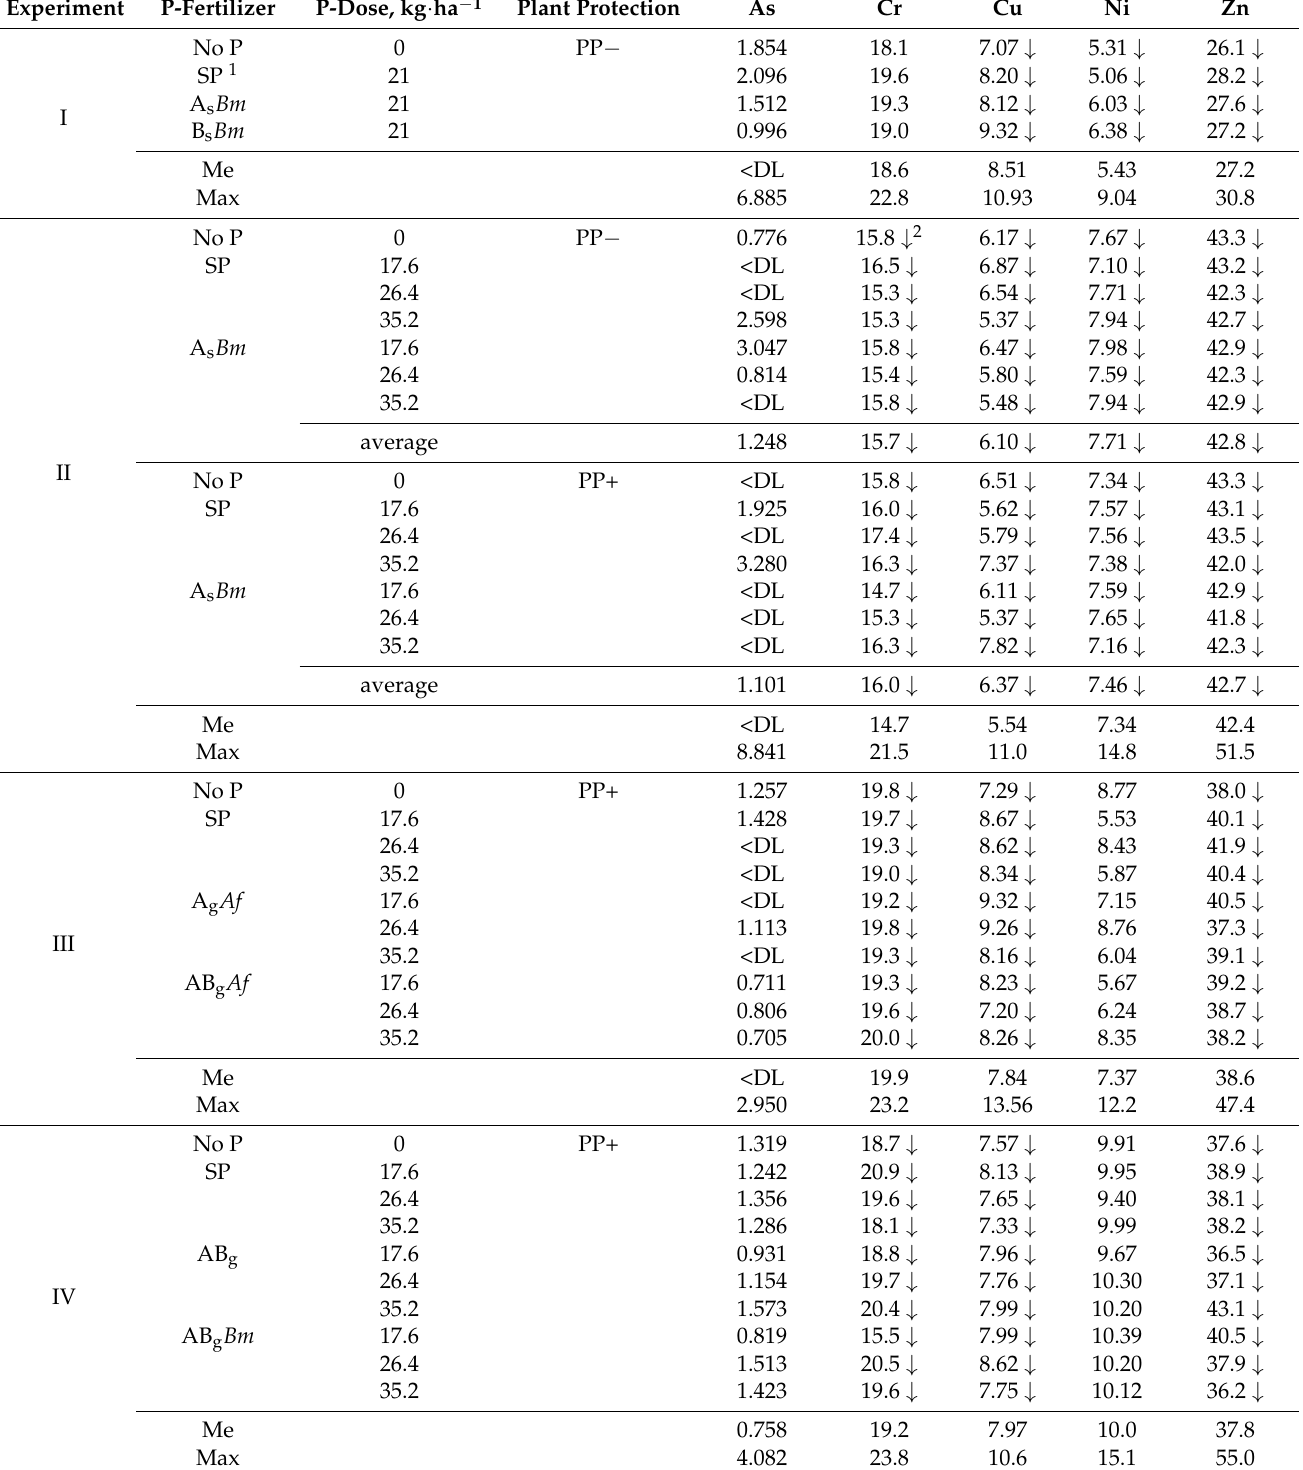
Table 10. PTE content in soil, mg · kg − 1 DM (n =